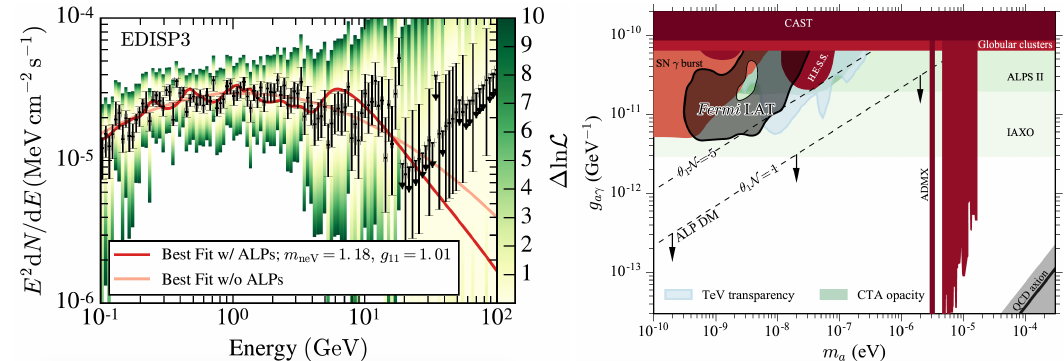
Figure 6. ( Left ) Likelihood curves for one event type and best spectral fits with and without ALPs. Reprinted from Ajello et al. [44]. ( Right ) Projected limits on the ALPs parameter space obtained with the Fermi -LAT study of the NGC 1275 data, compared with the results from other experiments at the time. Reprinted from Ajello et al. [44].